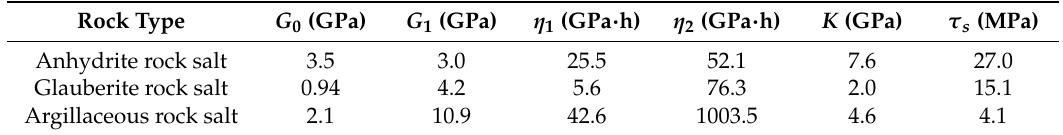
Table 6. Creep parameters of